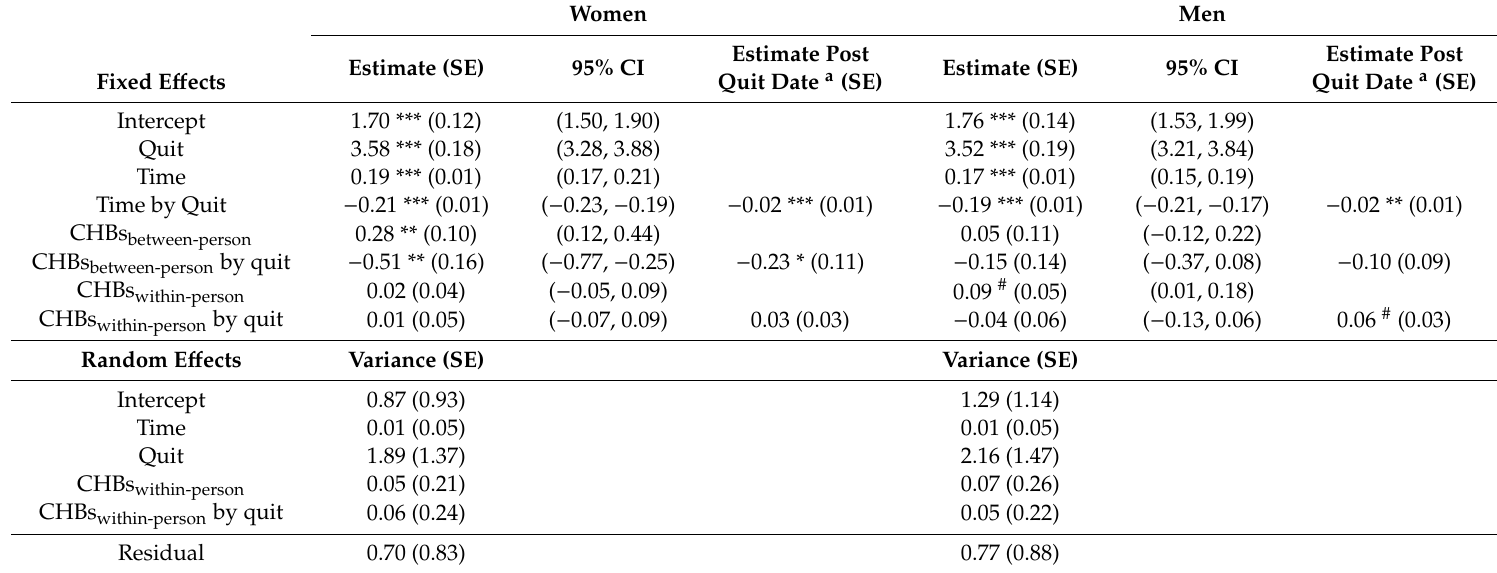
Table 2. Linear mixed model of daily intention to quit smoking regressed on daily CHBs and interaction with quit date for women and